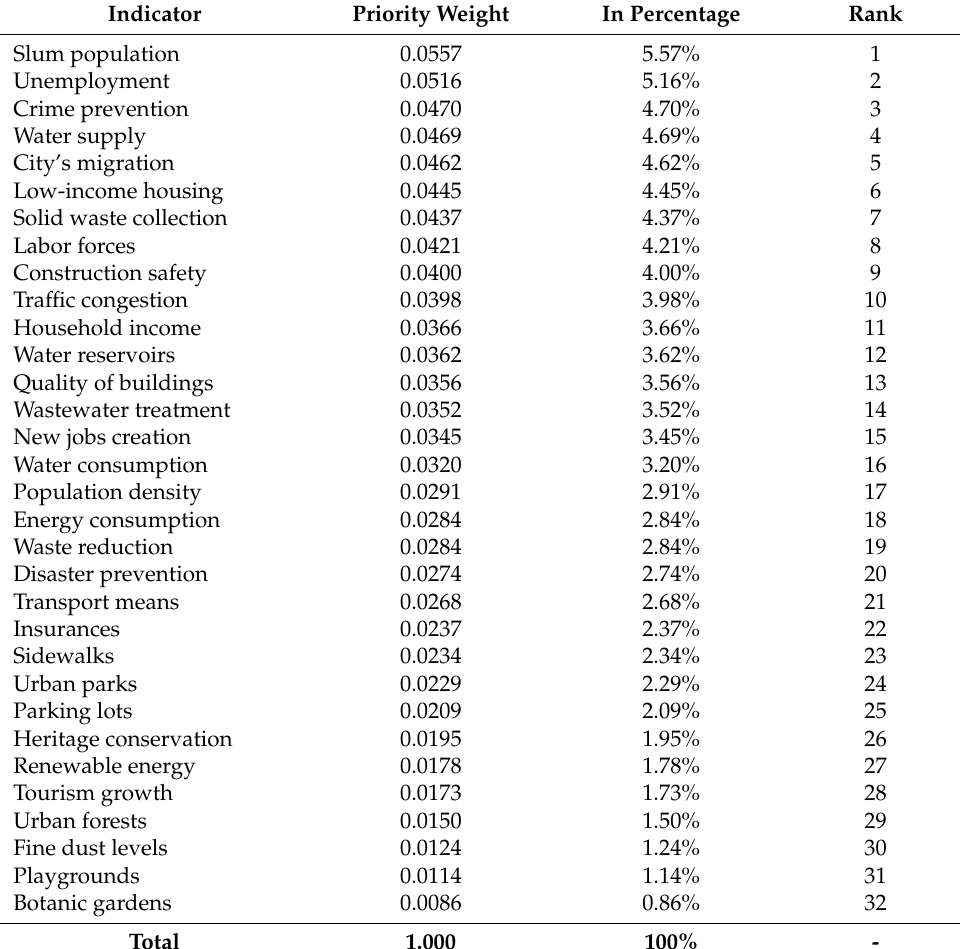
Table 4. The order of the 32 assessment indicators from high to low